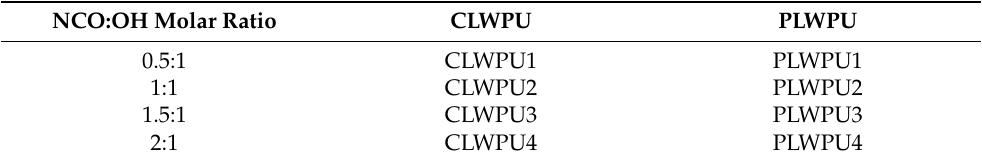
Table 2. PU adhesives made from CLW and PLW polyols and their corresponding NCO:OH molar